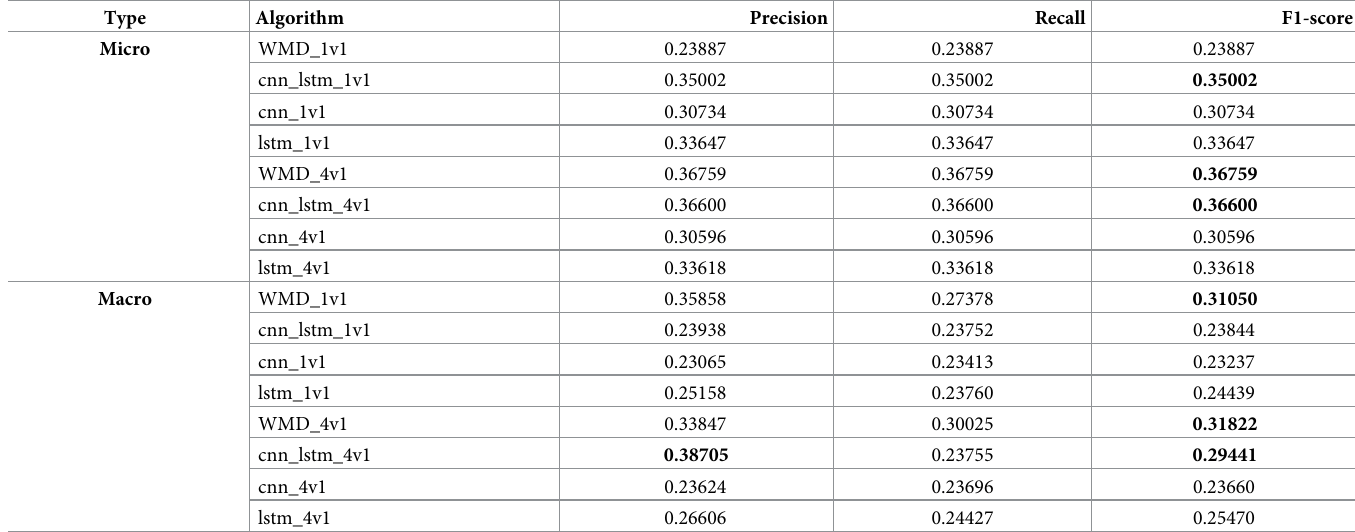
Table 3. Classification results on WMD and the three networks.